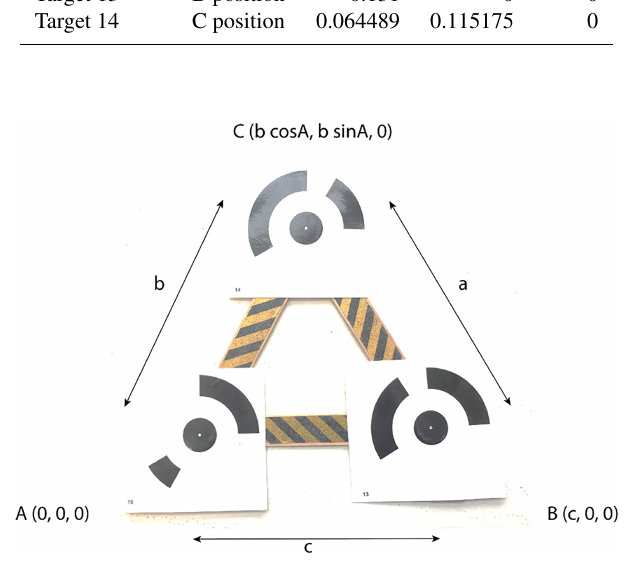
Figure 2. Triangle-coded control target. Each vertex of this triangle is a